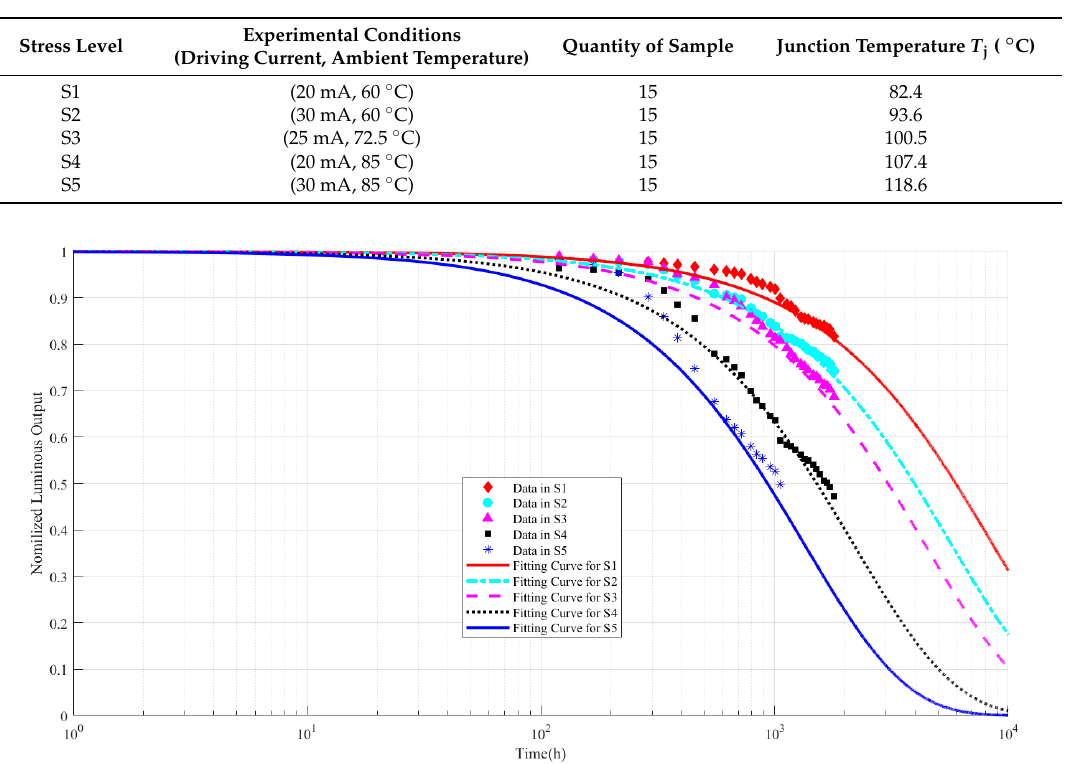
Figure 1. Degradation data [31] and trajectories under different stress levels.